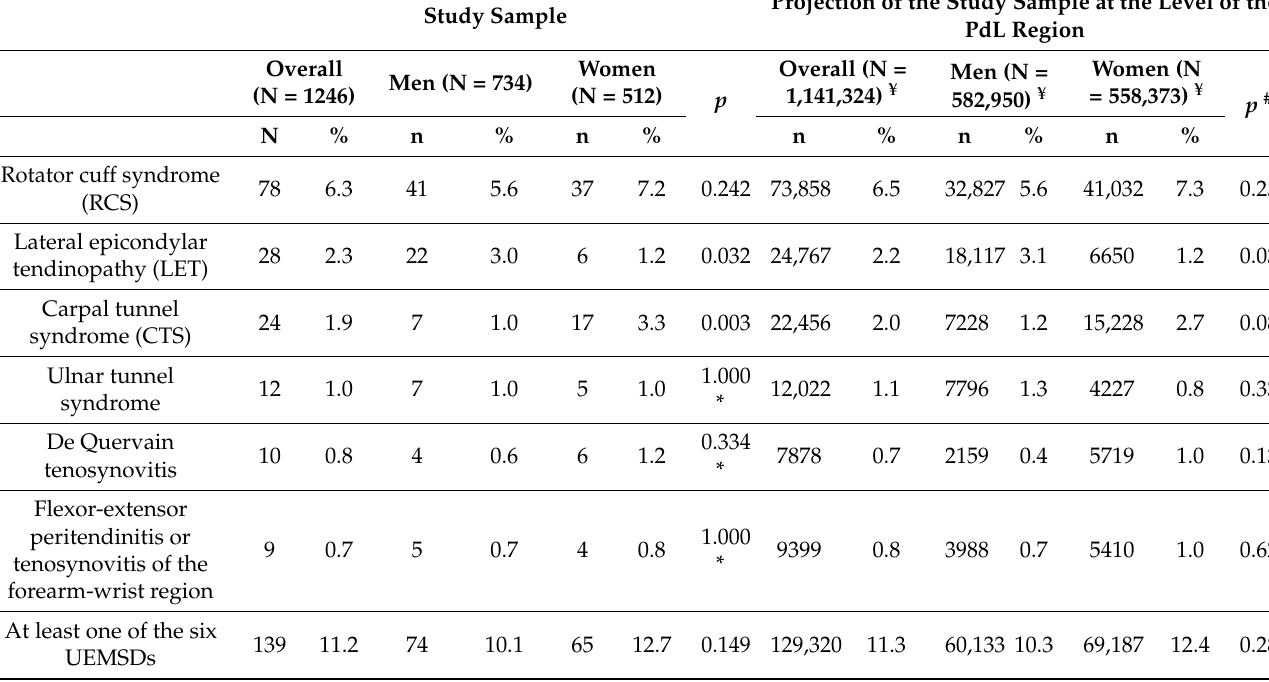
Table 1. Distribution of the six upper-extremity musculoskeletal disorders (UEMSDs) among the study population and its projection at the level of the Pays de la Loire (PdL) region.